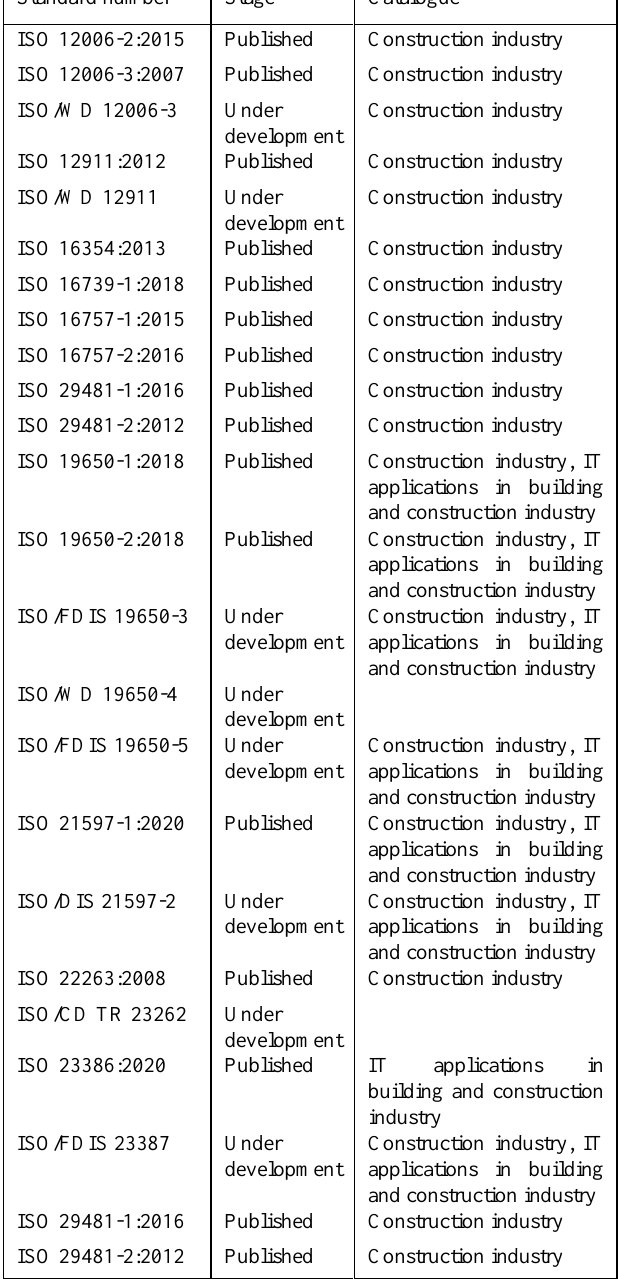
Table 1 - Standards developed by the ISO/TC 59/SC 13